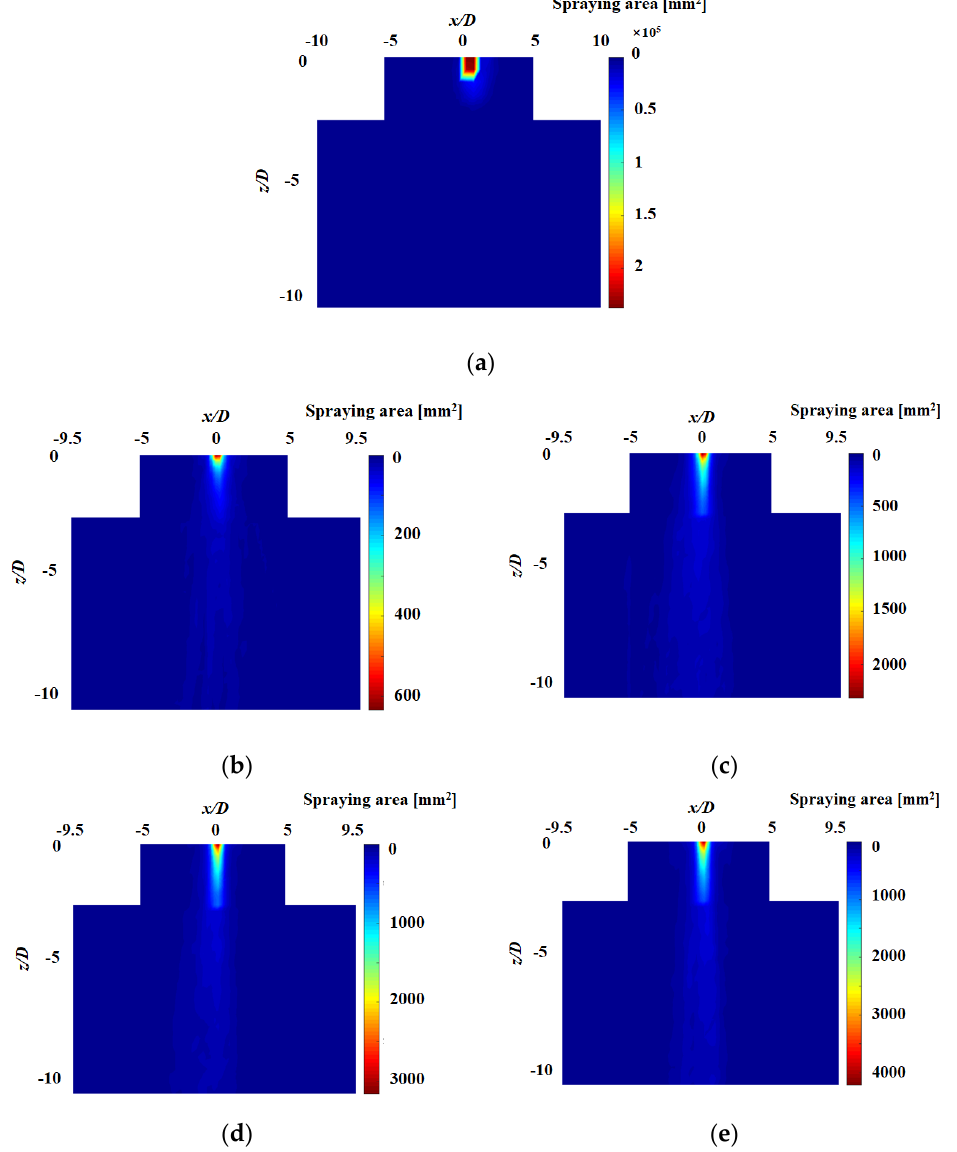
Figure 7. Contours of spraying area for ( a ) commercial and ( b – e ) proposed nozzle with a load of ( b ) 0 kg, ( c ) 30 kg, ( d ) 40 kg, and ( e ) 50